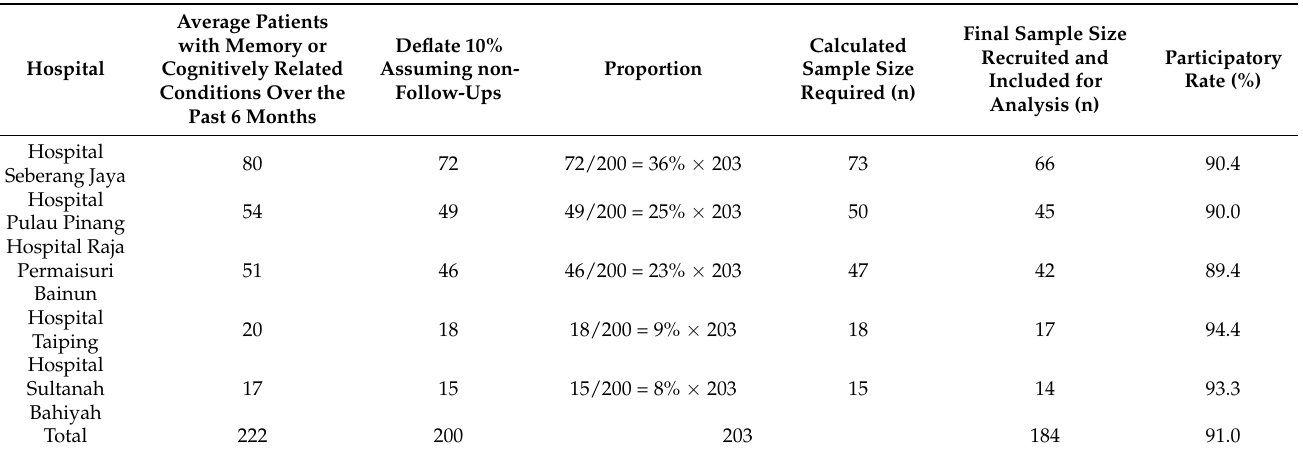
Table 1. The Required Sample Size